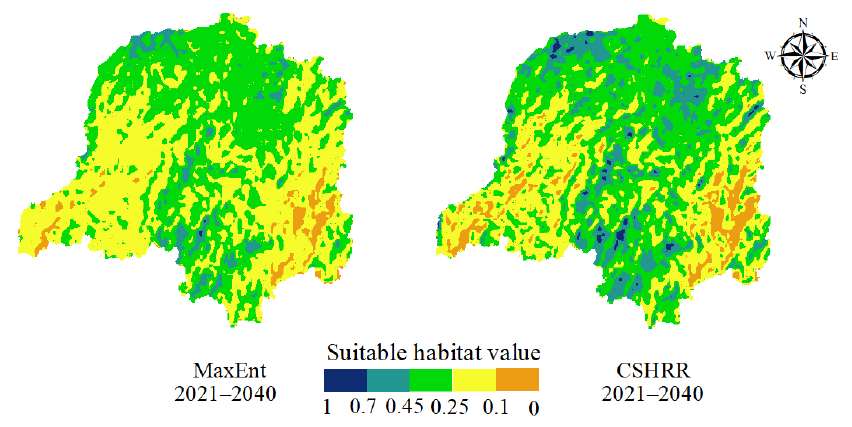
Figure 13. Reliability verification of CSHRR model.